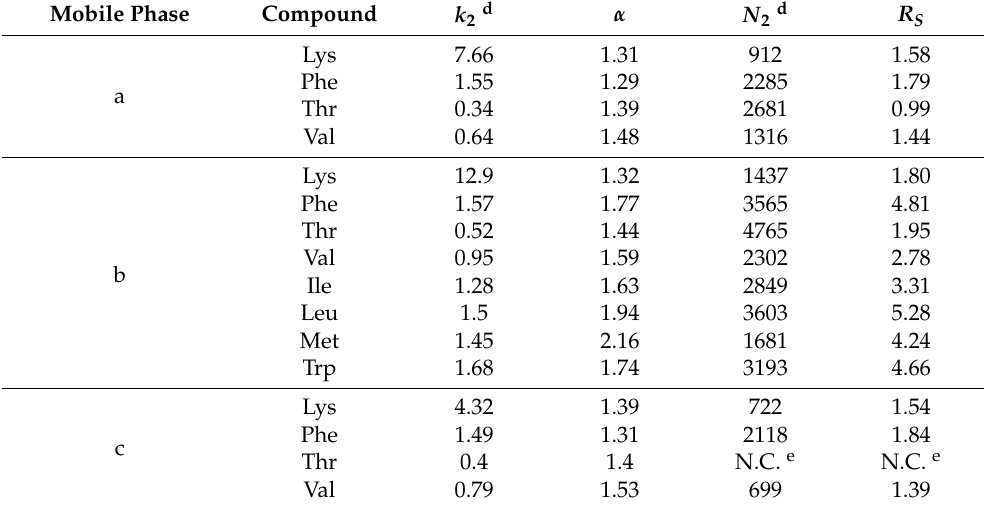
Table 3. Chromatographic performance obtained with the tested experimental conditions (see the footnote for details). k 2 : Retention factor of the second eluted D-enantiomer of each pair; α : separation factor; N 2 : number of theoretical plates of the second eluted enantiomer of each pair; R S : resolution factor. All the analyses were followed at 220